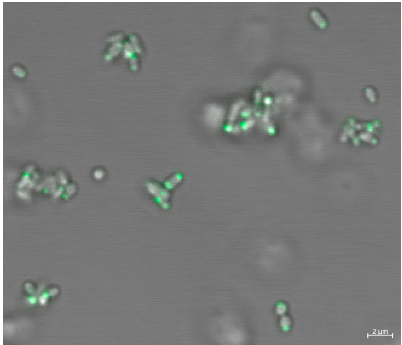
Figure 6. Cellular localization of MCP 514 in CheW-deficient A. fabrum mutant. Plasmid expressing eGFP-MCP 514 fusion protein was introduced into the atu051–cheW 1 –cheW 2 triple-deletion mutant Δ 514 Δ w . Cells were grown to the middle-log phase and observed by using confocal laser-scanning microscopy.